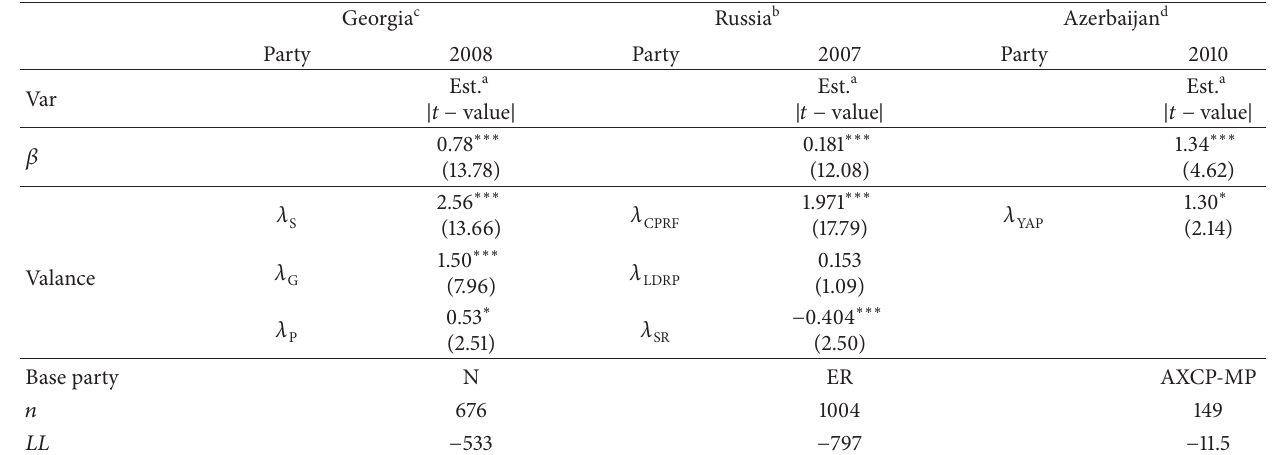
Table 5: MNL spatial model in anocracies.